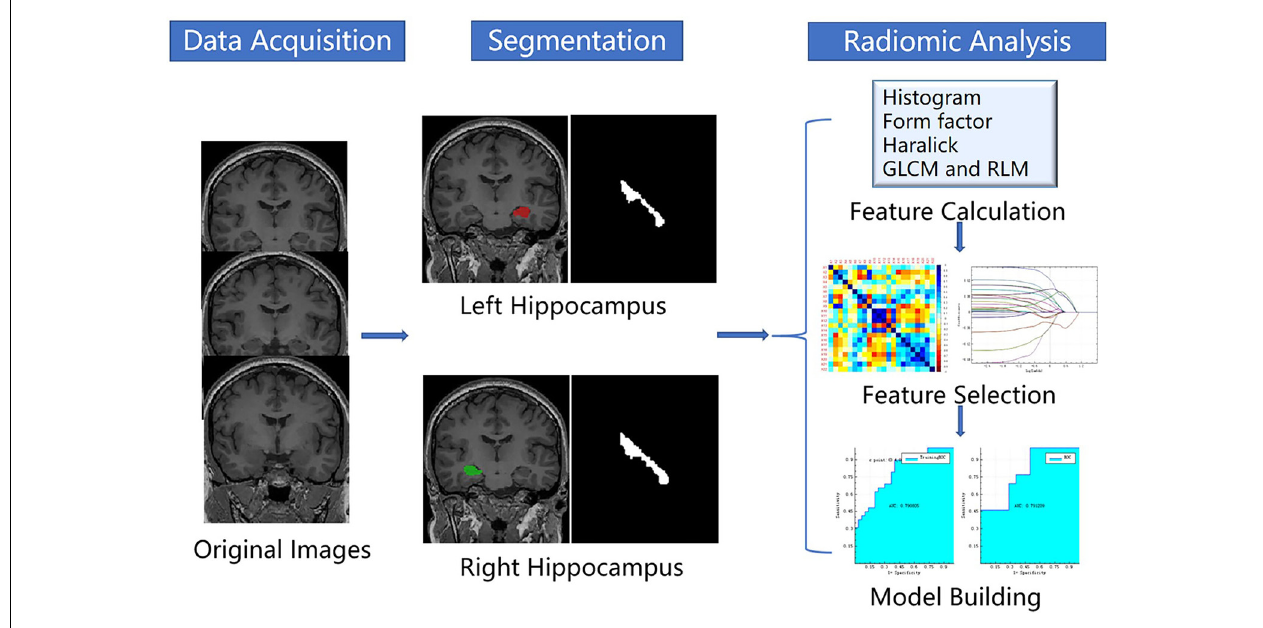
FIGURE 2 | Flowchart of the radiomic process.